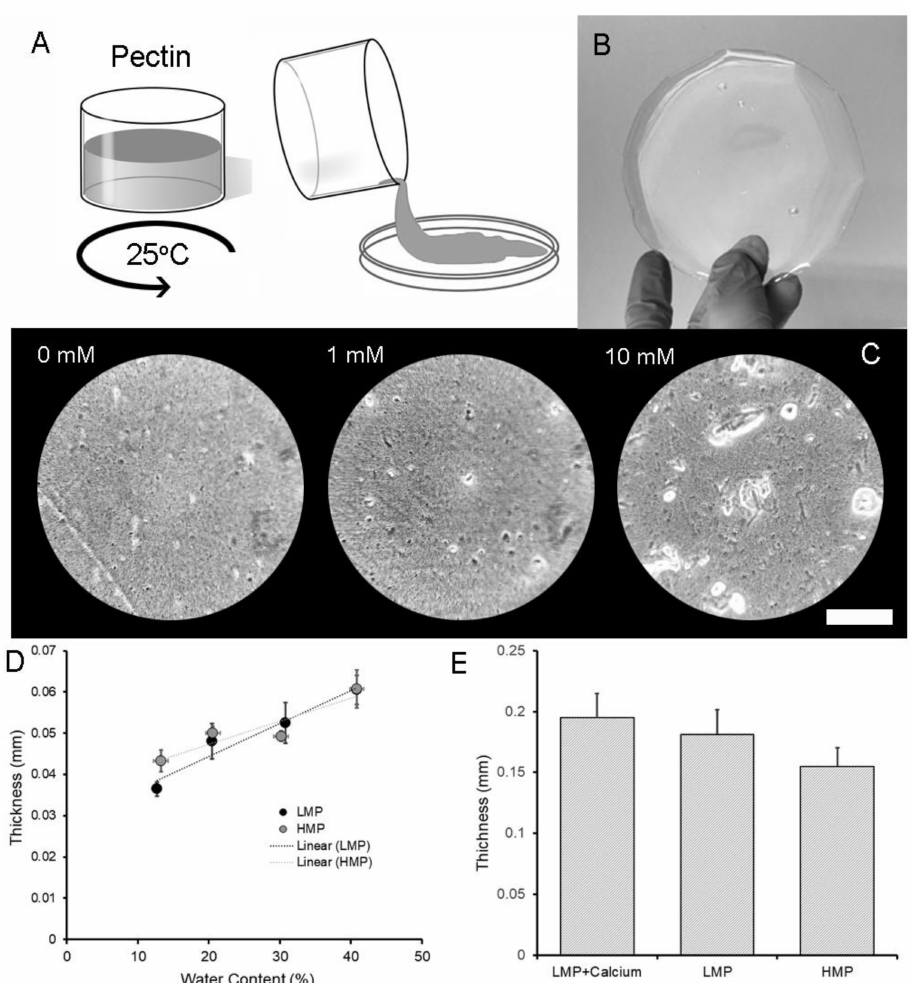
Figure 1. Preparation of pectin polymers. ( A ) Powered pectin with low methyl esterification